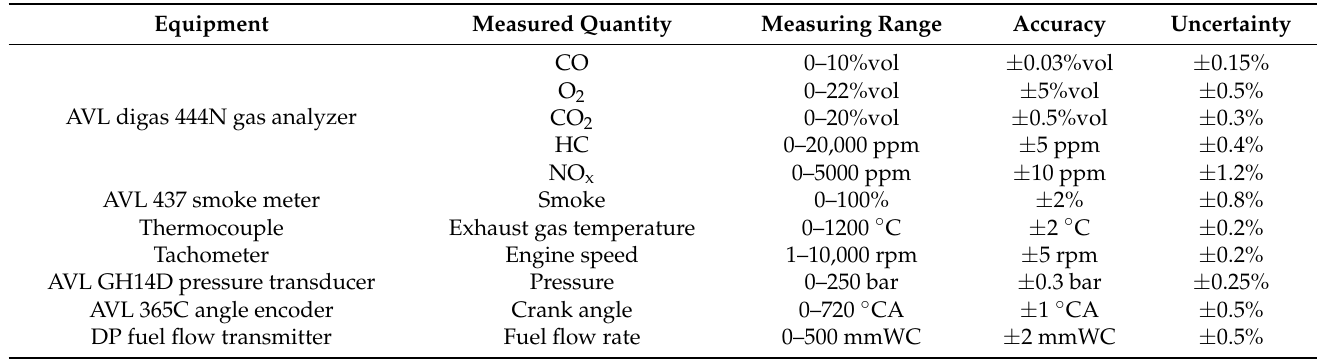
Table 4. Range, accuracy, and uncertainty of the